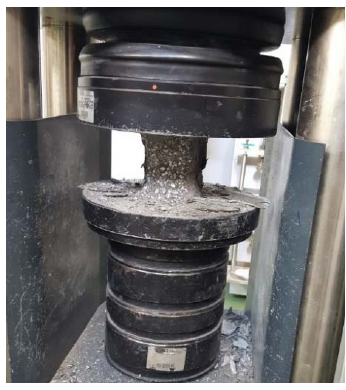
Table 8. Properties of the considered concrete mixtures.